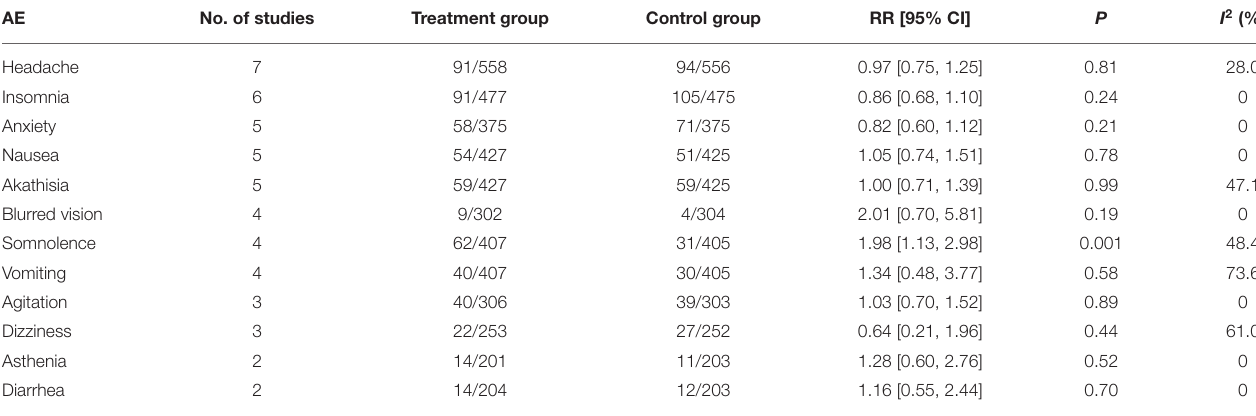
TABLE 2 | Treatment-emergent adverse events (high- vs. low-dose